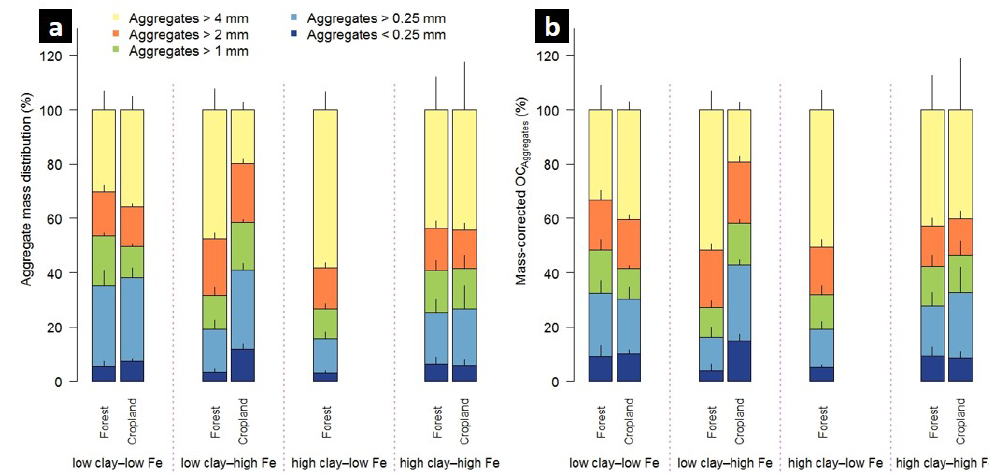
Figure 1. Aggregate size distribution of the combined 0–5 and 5–10cm depth increments (a) and relative mass-corrected OC contents (b) along the mineralogical combinations. Clay represents the weight sum of kaolinite and gibbsite present in the < 2µm fraction after removal of OM and pedogenic Fe oxides, and Fe denotes the content of pedogenic Fe oxides extracted with dithionite–citrate–bicarbonate. Sample numbers for the combinations are as follows: “low clay–low Fe” under forest ( n = 4), “low clay–high Fe” under forest ( n = 4), “high clay– low Fe” under forest ( n = 3), and “high clay–high Fe” under forest ( n = 7), with all cropland combinations ( n =